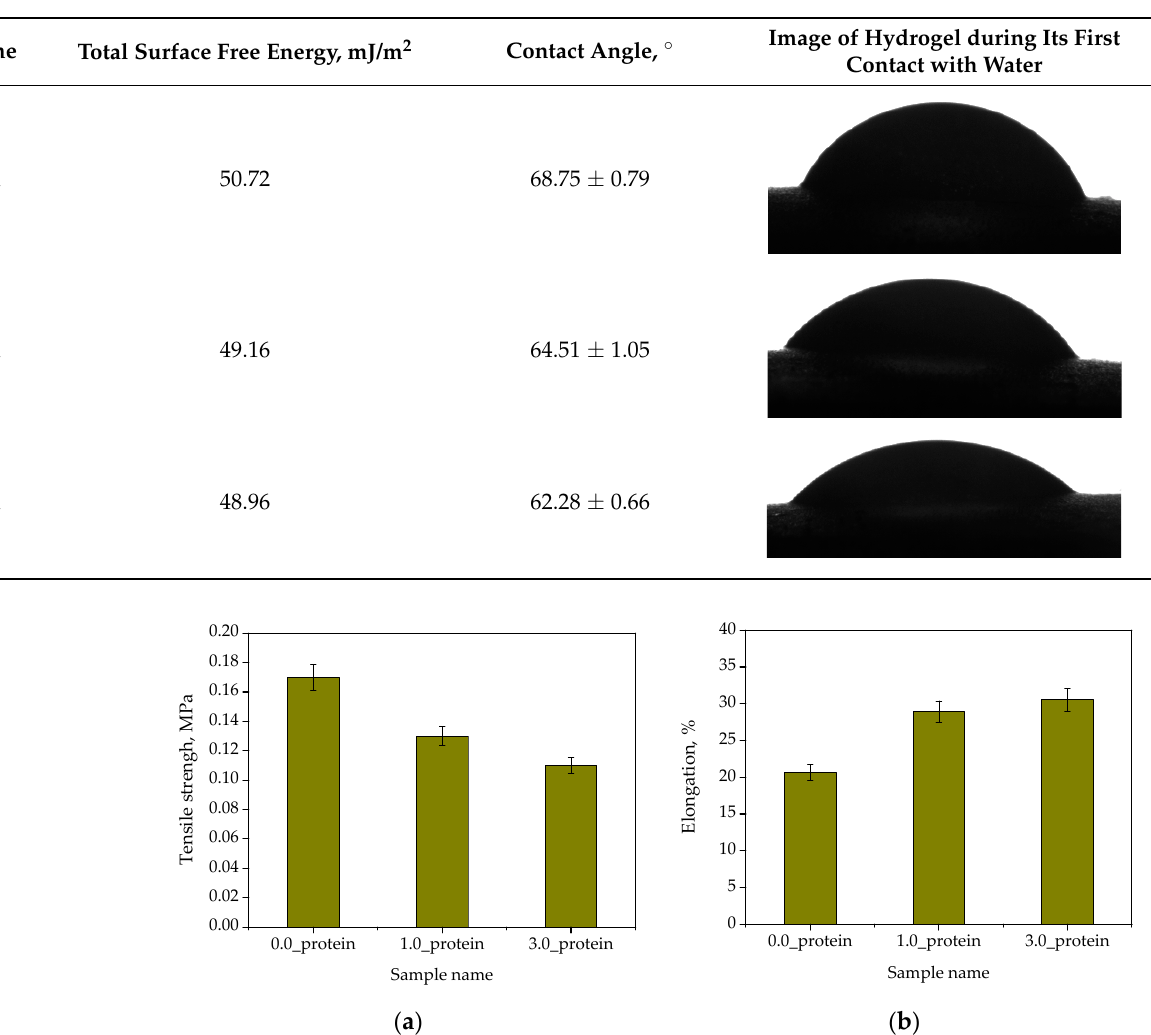
Figure 10. Results of the mechanical evaluation of unmodified hydrogels and hydrogels containing protein particles: tensile strength ( a ) and percentage elongation ( b ) ( n —number of repetitions, n = 3).